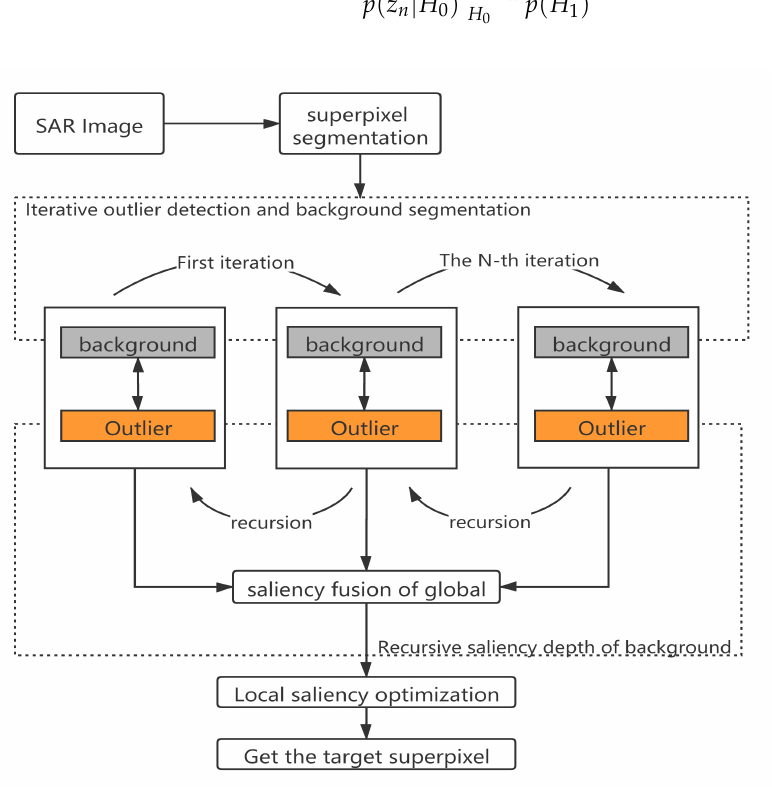
Figure 1. Target detection flow chart based on iteration and